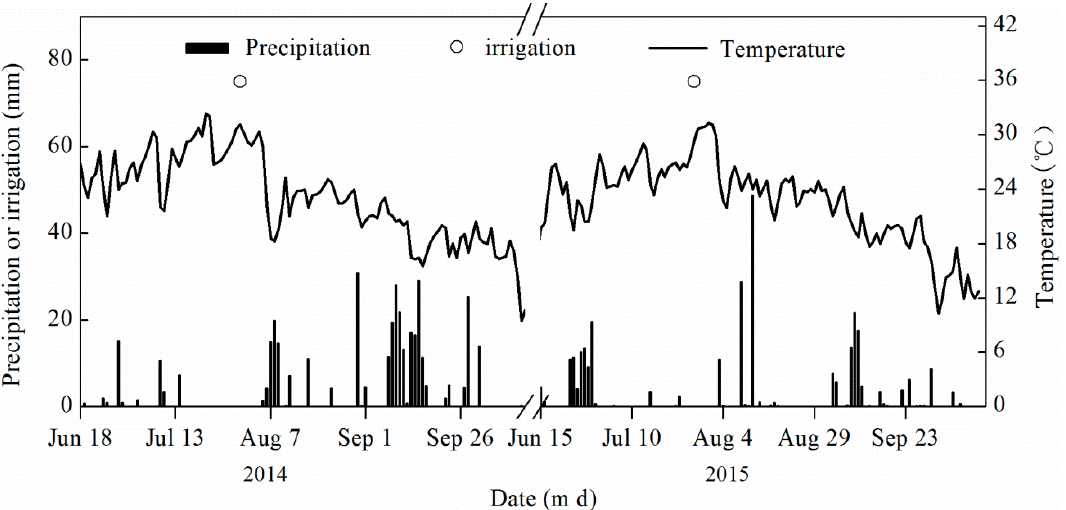
Figure 1. Daily rainfall, irrigation, and average daily temperature recorded during the summer maize growing seasons in 2014 and 2015.